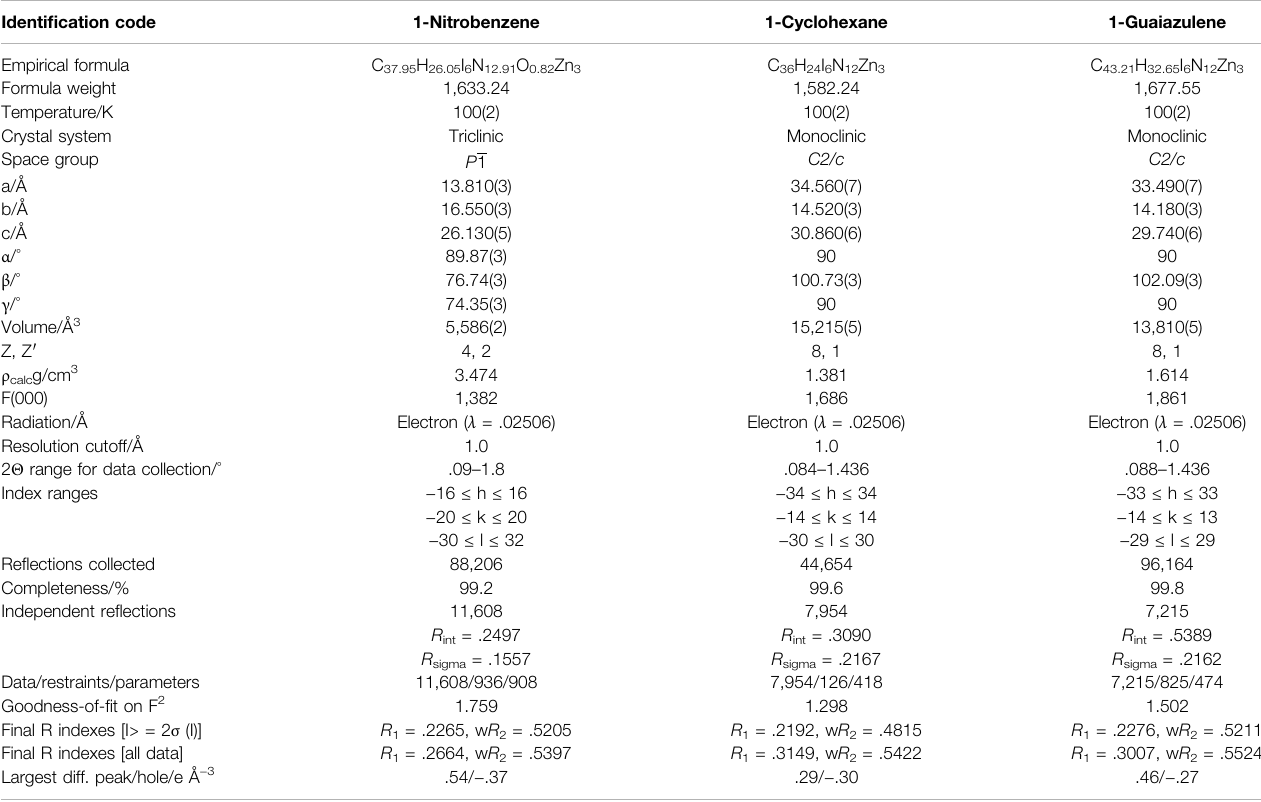
TABLE 1 | The crystallographic statistics and re fi nement detail of 1-Nitrobenzene, 1-Cyclohexane, and 1-Guaiazulene. Identi fi cation